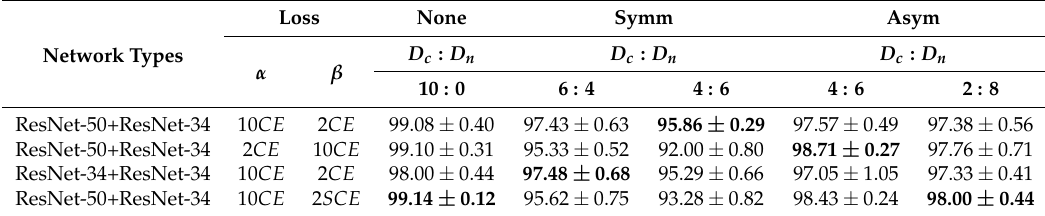
Table 10. Classification accuracy (%) on the UC Merced Land-use test set after changing each module from our